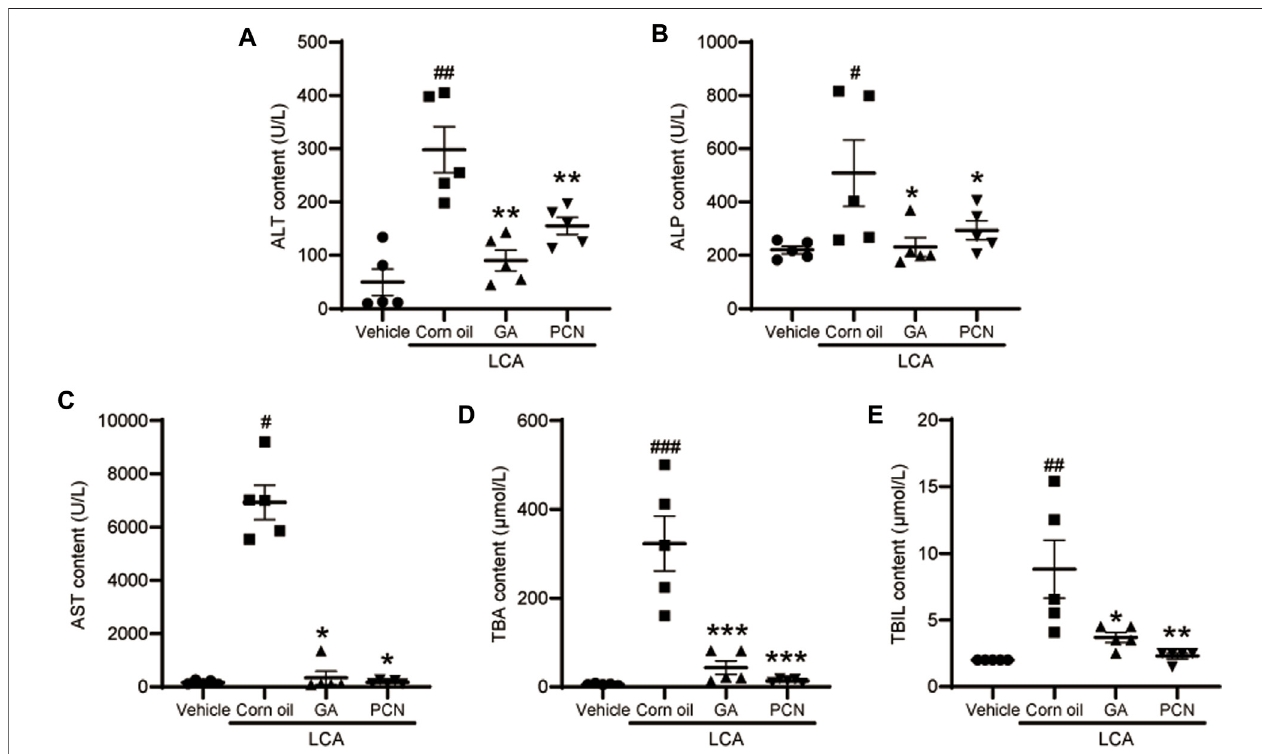
FIGURE 2 | Effect of GA on plasma levels of biochemical indicators. (A) ALT; (B) ALP; (C) AST; (D) TBA; and (E) TBIL. Data are shown as mean ± SD ( n = 5). # p < 0.05, ## p < 0.01, and ### p < 0.001 vs. vehicle group; p p < 0.05, pp p < 0.01, and ppp p < 0.001 vs. LCA group.